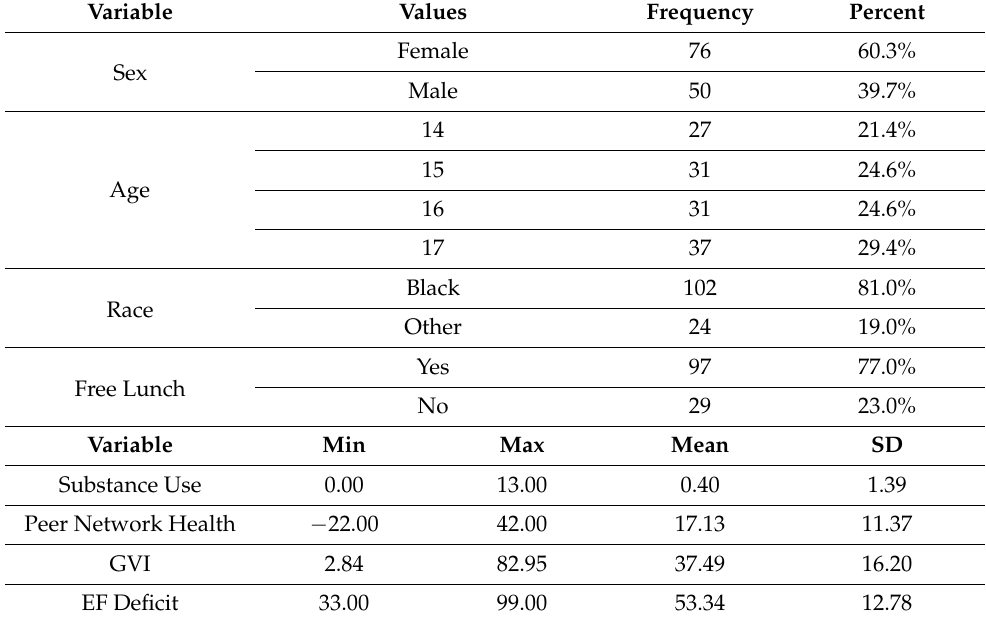
Table 1. Descriptive Statistics ( n = 126).